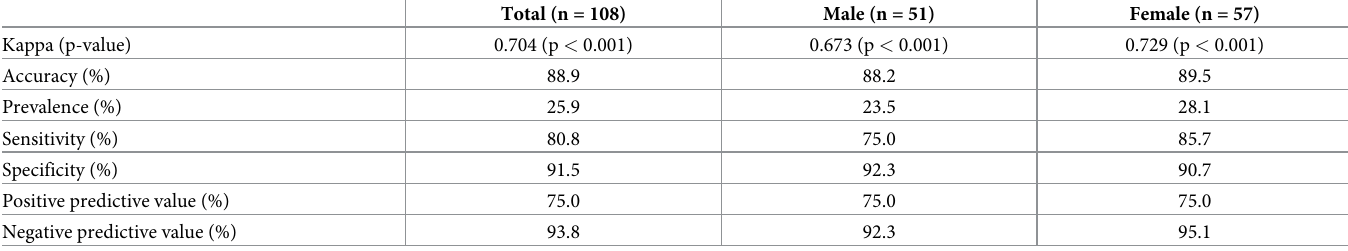
Table 3. Accuracy test for sensitivity and specificity between different methods for low muscle mass assessment, using EWGSOP2 sarcopenia criteria in cancer